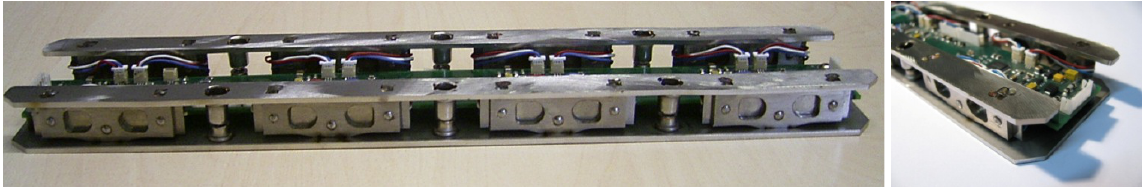
Figure 13. Assembled WIM sensor module